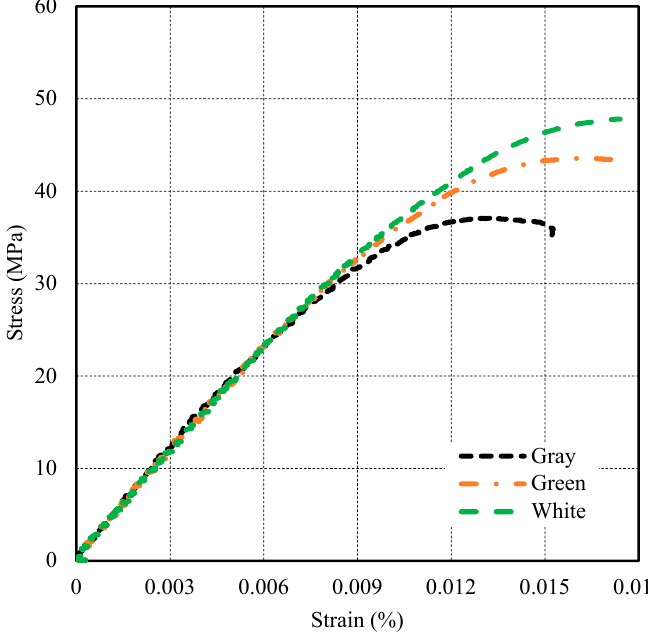
ff ect of sample color on the stress-strain Figure 17. Effect of sample color on the stress-strain curve. Figure 17. E